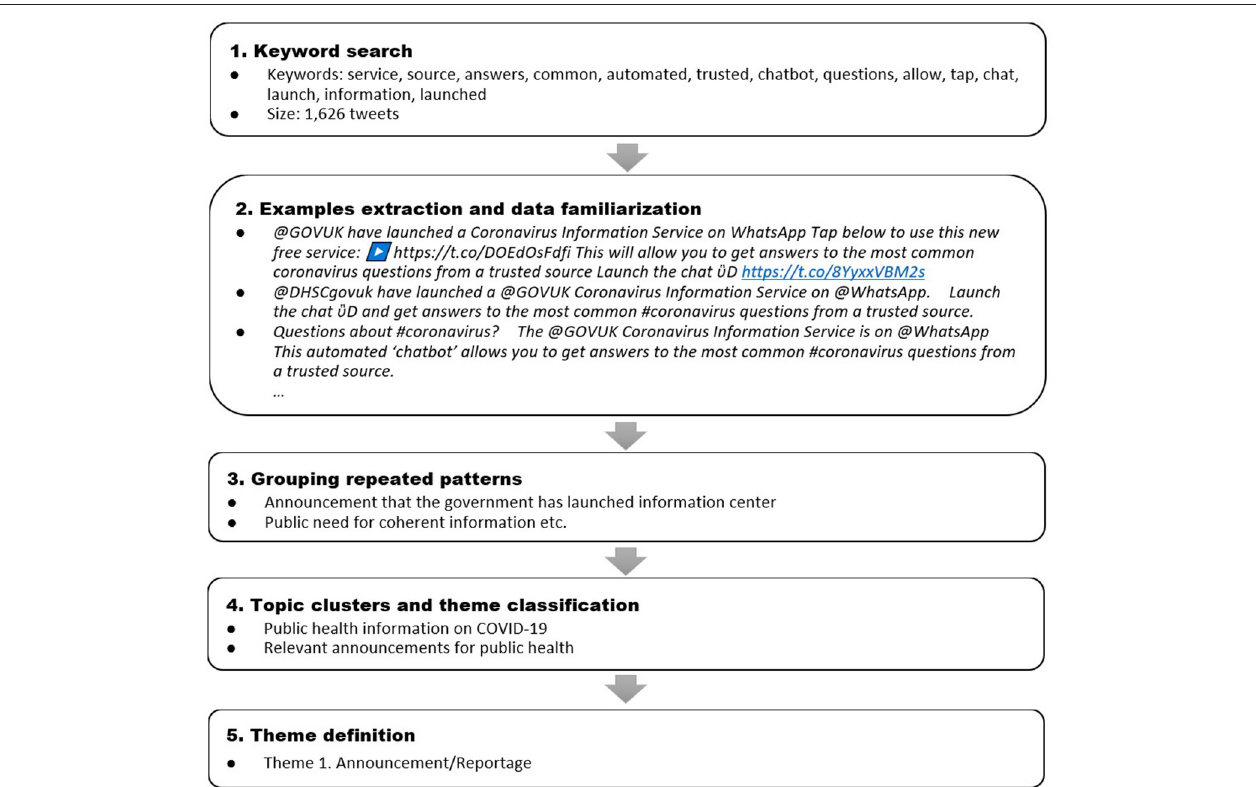
FIGURE 4 | Flowchart displaying thematic classification process (Example from the @UK_gov account).